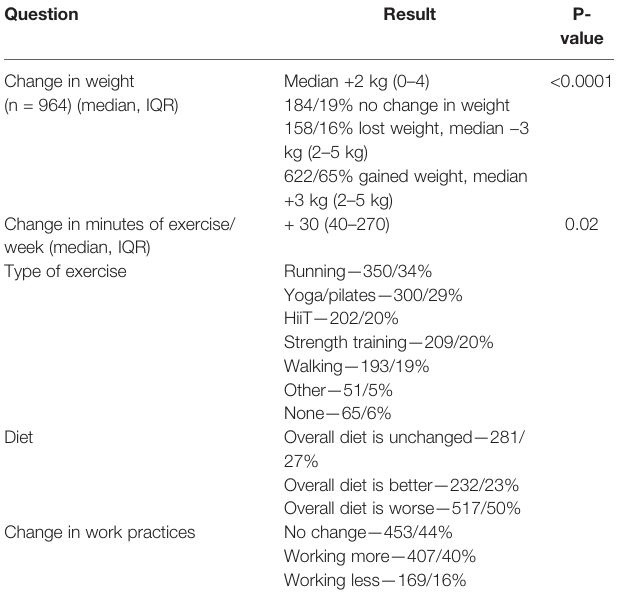
TABLE 4 | Changes in lifestyle during the COVID-19